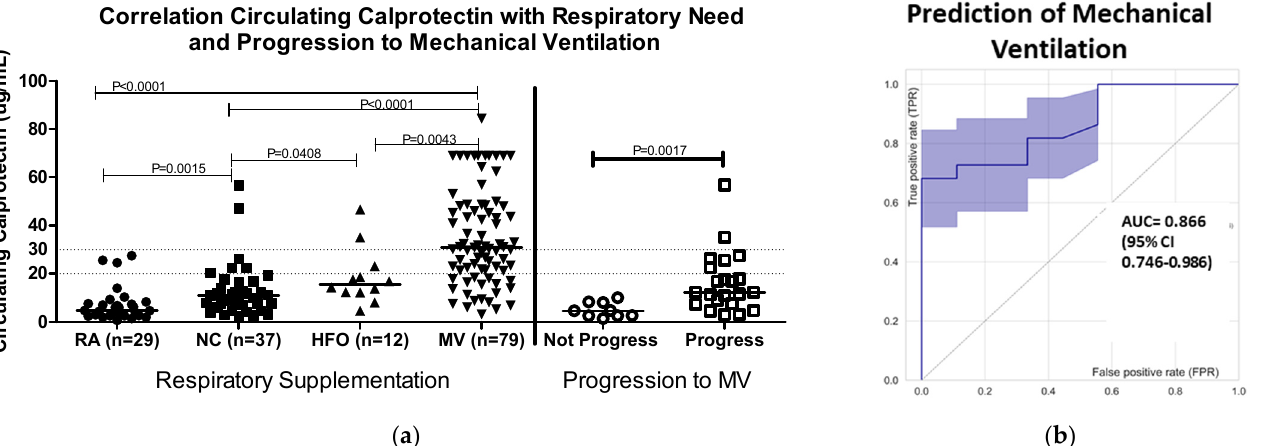
Figure 1. Circulating calprotectin levels ( a ) in relation to levels of oxygen supplementation (left-hand side of figure) and progression to mechanical ventilation (MV) at ≥ 1 day post-admission. Patients who progressed (N = 22) had significantly higher cCP levels compared to individuals (N = 9) who did not progress (Mann–Whitney, p = 0.0017). Dotted lines at 20 and 30 µ g/mL indicate cutoffs referred for prediction of MV described in Section 3.1. ( b ) Receiver operating characteristic (ROC) curve analysis of cCP in relation to progression to MV. The area under the curve (AUC) was 0.866 (95% CI 0.746–0.986), showing strong discrimination between patients who progressed to MV and those who did not progress. Abbreviations: RA, room air; NC, nasal cannula; HFO, high ‐ flow oxy ‐ gen; MV, mechanical ventilation.